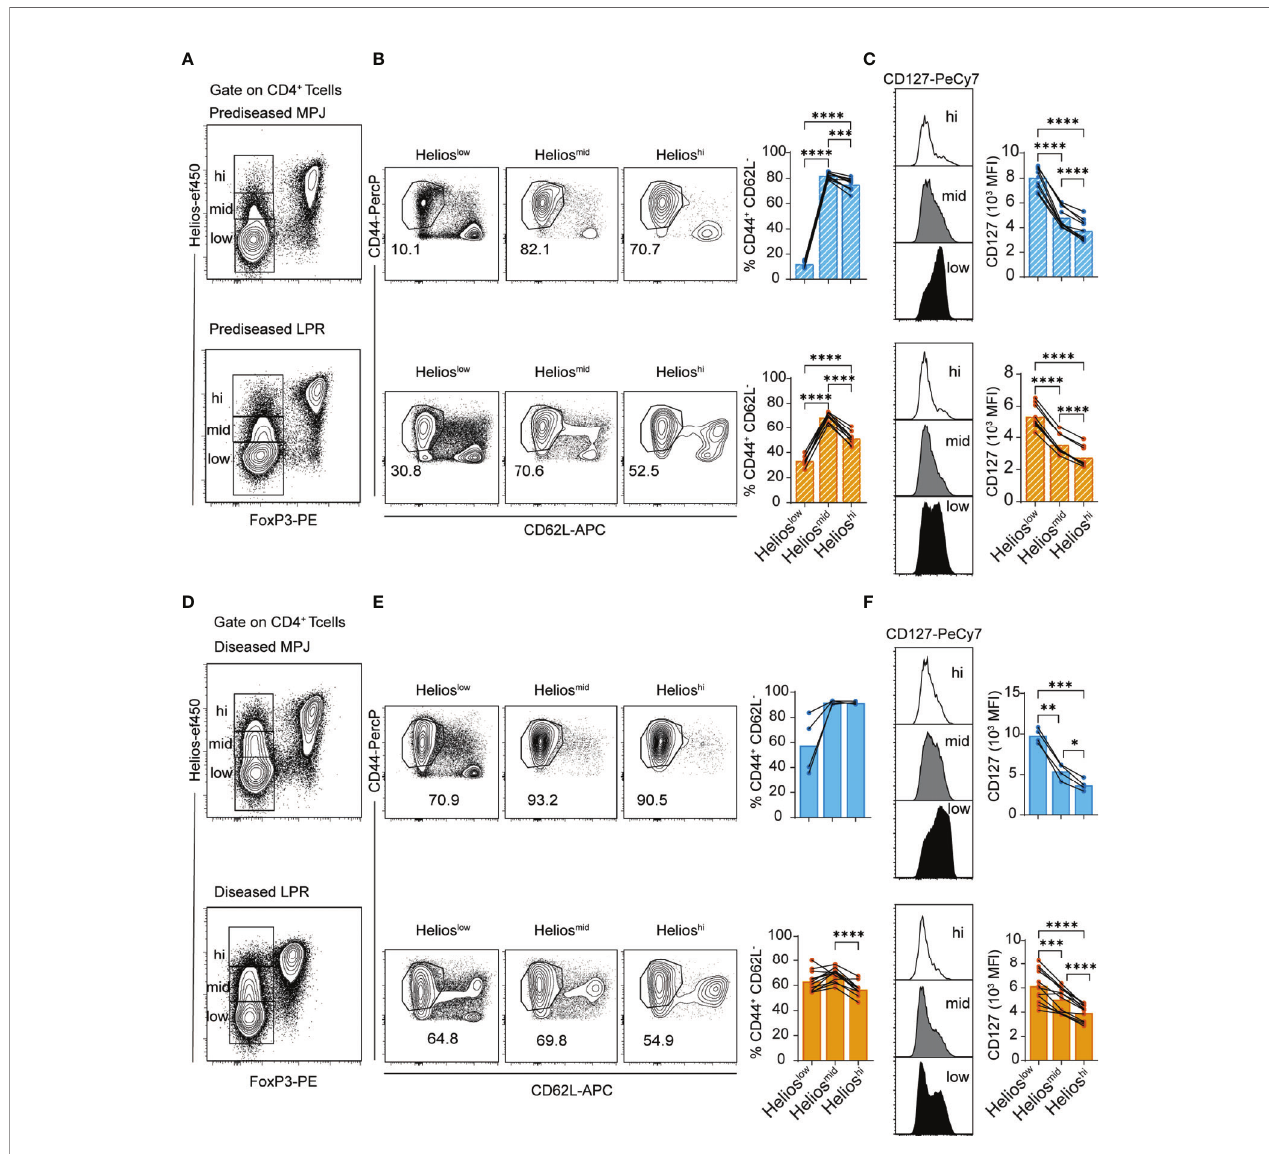
FIGURE 2 | Helios expression and effector phenotype of CD4 + Tconvs in MPJ and LPR mice. (A) Representative fl ow cytometry plots pregated on splenic CD4 + T cells (CD3 + CD4 + ) from prediseased MPJ (top) and LPR (bottom) mice, in which three different CD4 + Tconv (FoxP3 − ) populations are indicated through their Helios expression (Helios low/mid/hi ). (B) Representative effector phenotype (CD44 + CD62L − ) plots of Helios low , Helios mid and Helios hi CD4 + Tconv cells, and their percentages (right) relative to prediseased MPJ and LPR mice. (C) Representative CD127 histograms gated on CD4 + Tconv Helios low , Helios mid , or Helios hi (left), and their MFI quanti fi cation (right) in prediseased MPJ and LPR mice. (D) Same as in (A) but from diseased mice. (E) Same as in (B) but from diseased mice. (F) Same as in (C) but from diseased mice. The data represent the mean ± SD: *P < 0.05; **P < 0.01; ***P < 0.001; ****P < 0.0001 by RM one-way ANOVA with a Tukey multi- comparison post-test. Each point represents a single animal: prediseased MPJ (pre.MPJ), n = 10 (A – C) diseased MPJ (dis.MPJ), n = 4 (A – C) prediseased LPR (pre.LPR), n = 9 (D – F) and diseased LPR (dis.LPR), n = 12 (D – F)